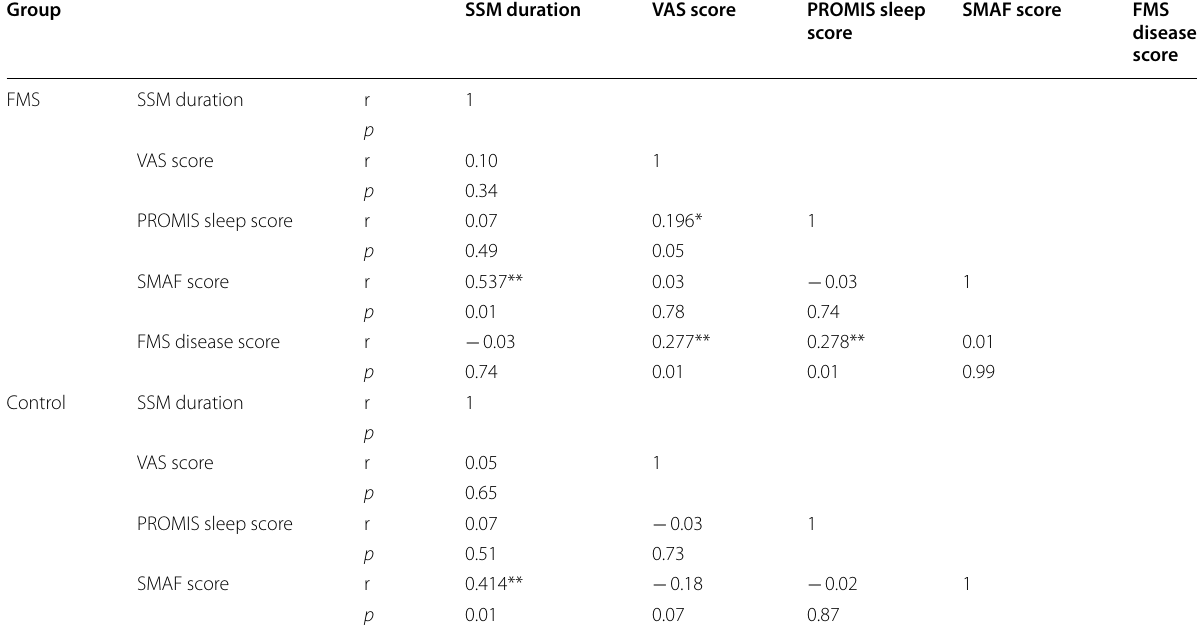
**The r correlation coefficient is significant